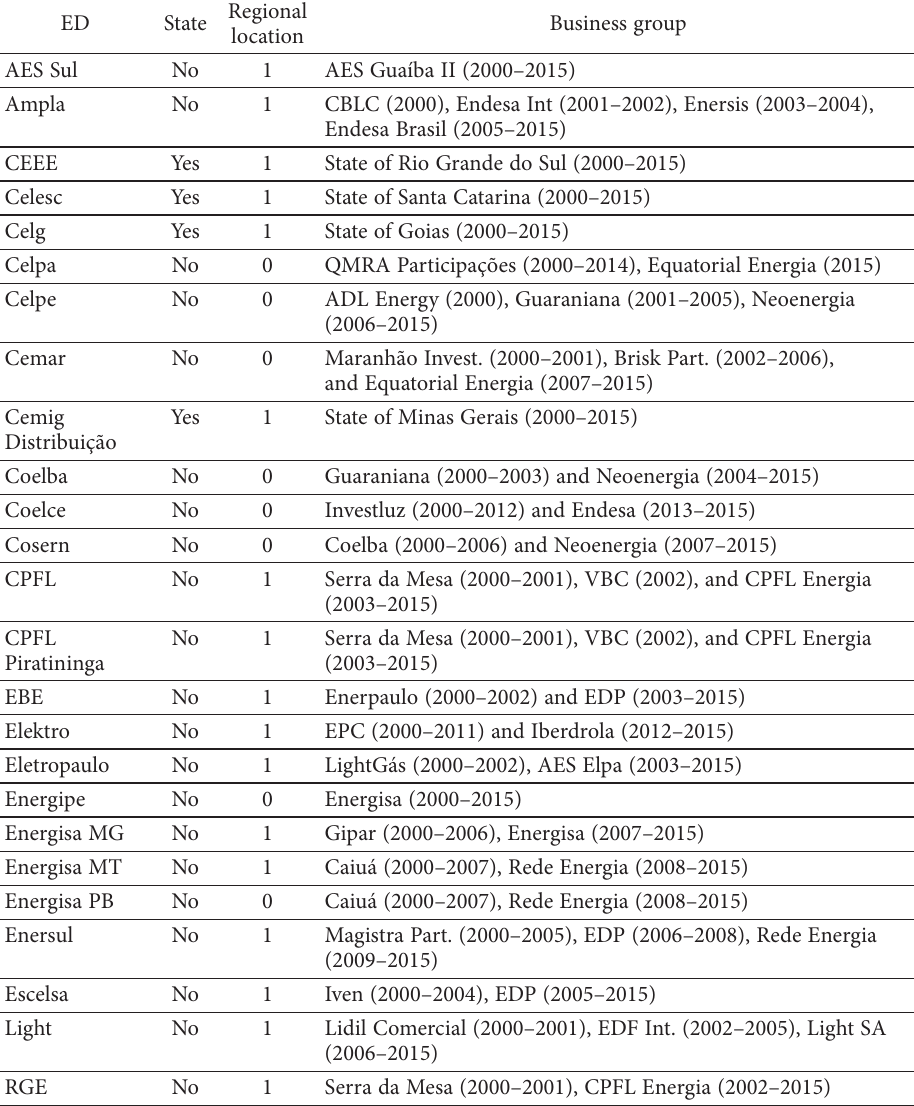
Table 1. Description of the 25 EDs composing the sample Regional ED State